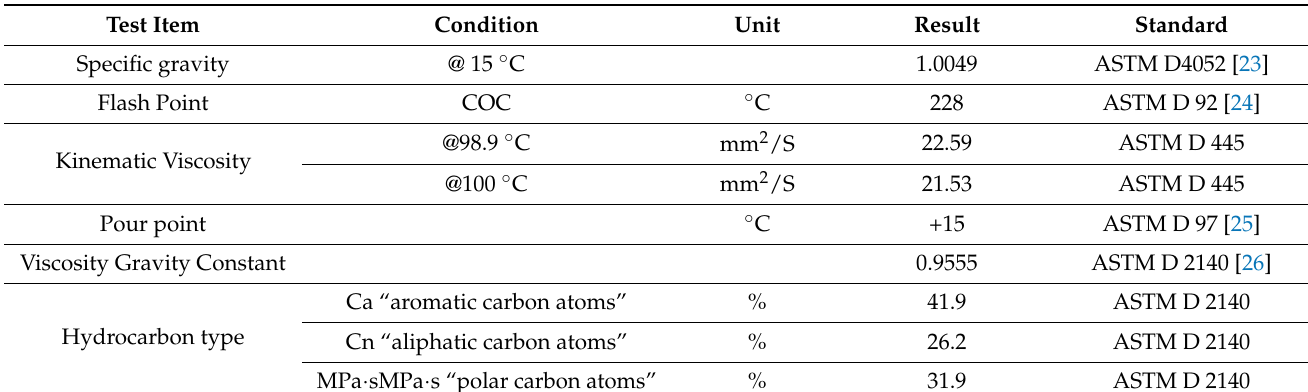
Table 3. Properties of processed